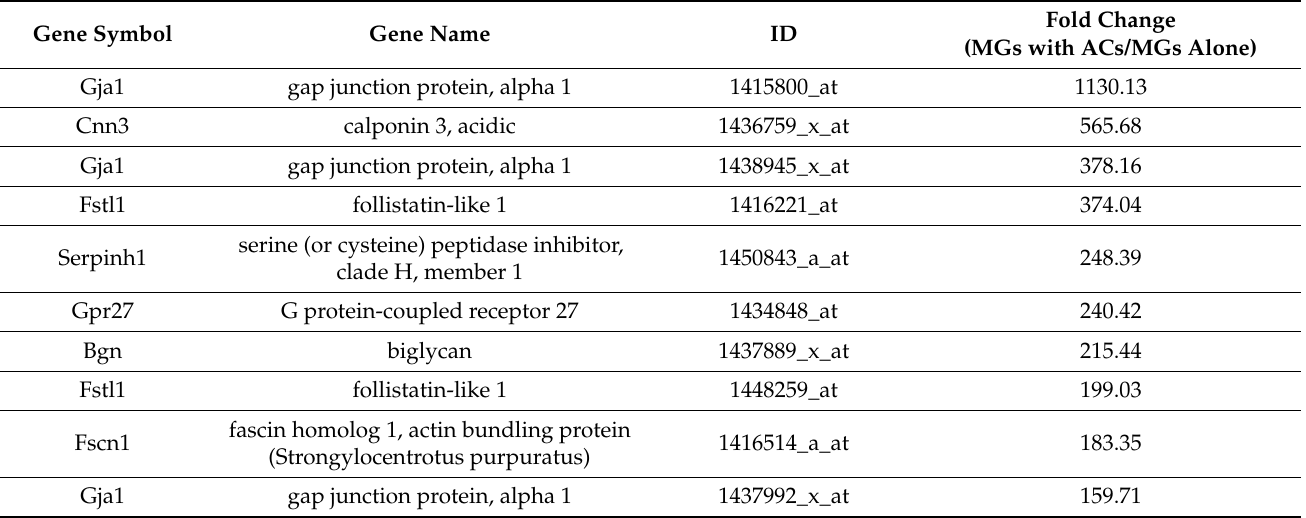
Table 2. List of top 10 highly expressed genes in MGs with ACs compared with MGs